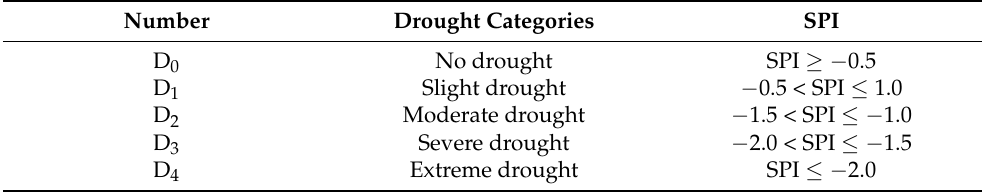
Table 2. Drought category classification based on